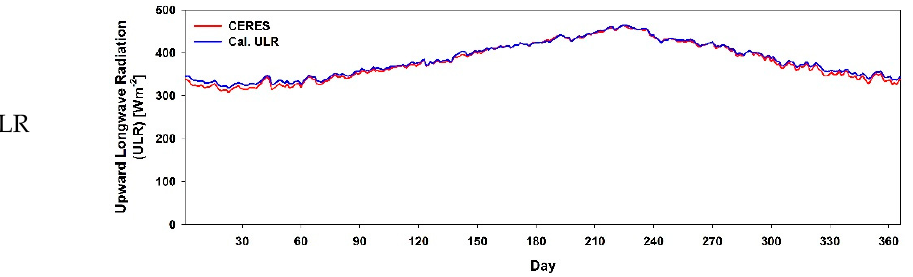
Figure 8. Daily mean time series distribution of CERES and calculated ( a ) OLR; ( b ) DLR; and ( c ) ULR. Table 10. Bias, RMSE and correlation coefficient (R) of CERES and calculated radiation components using 2016 daily mean data. The mean, bias, and RMSE units are Wm − 2 . CERES Mean Bias RMSE R ISR 337.47